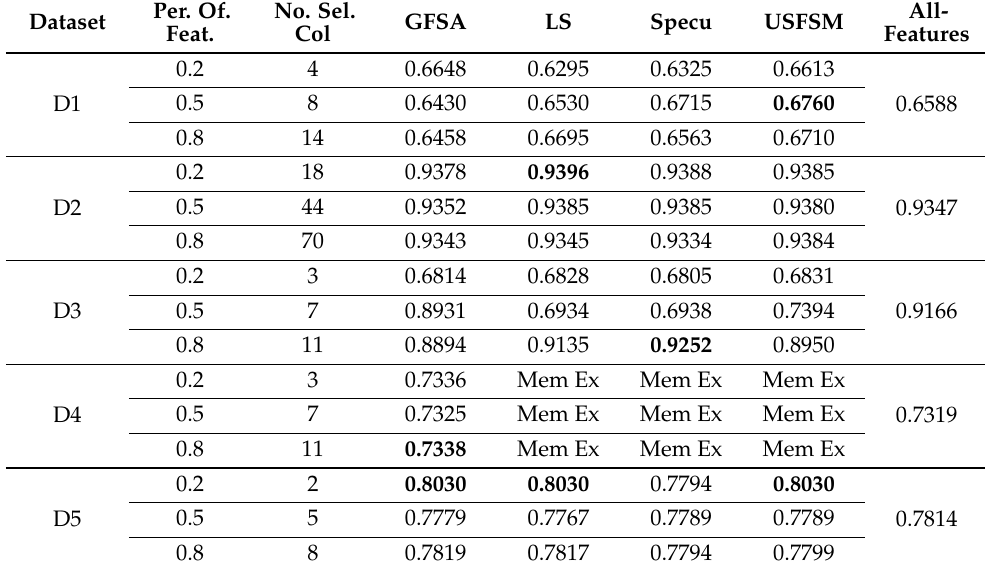
Table 4. KNN Accuracy for insurance datasets.